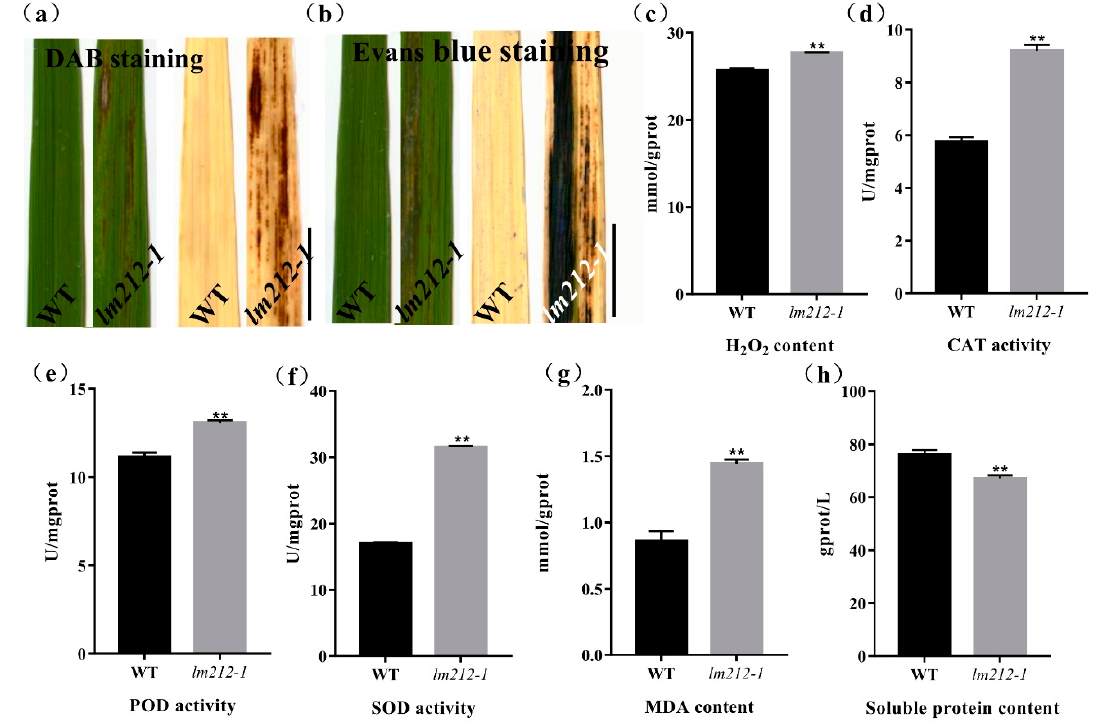
Figure 3. Histochemical staining and physiological detection. ( a ) DAB staining in leaves of WT and lm212-1 at the tillering stage. ( b ) Evans blue staining in leaves of WT and lm212-1 at the tillering stage. Scale bars, 1 cm. ( c – h ) Measurements of activities and contents in WT and lm212-1. ( d ) CAT activity ( e ) POD activity, ( f ) SOD activity, ( e ) H 2 O 2 content, ( g ) MDA content, ( h ) soluble protein content. ** p < 0.01 by the Student’s t -test. Data represent means ± SD of three biological replicates.